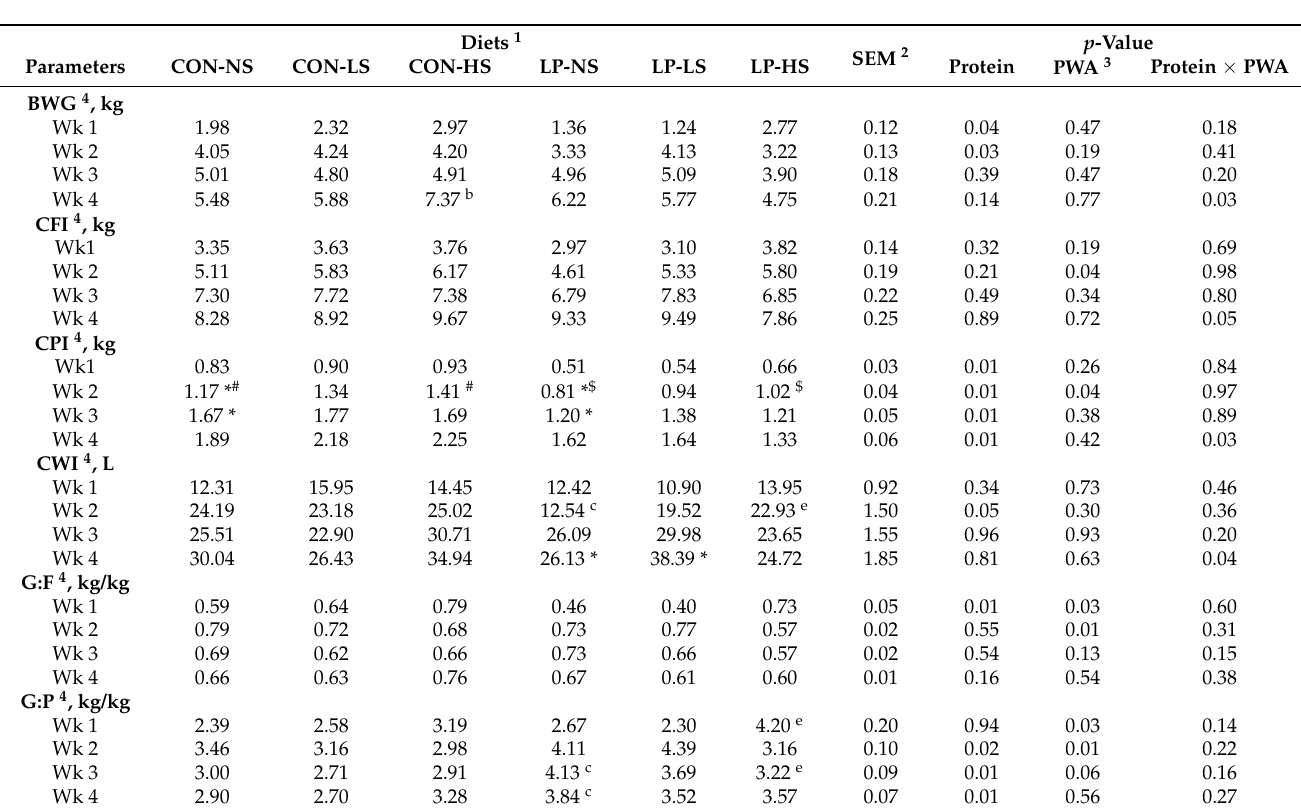
Table 4. Weekly growth performance of nursery pigs fed with two levels of dietary protein and three levels of a phytogenic water additive.